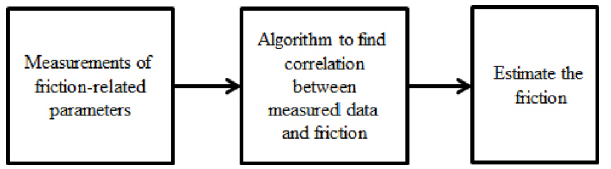
Fig. 2 Experiment-based flowchart